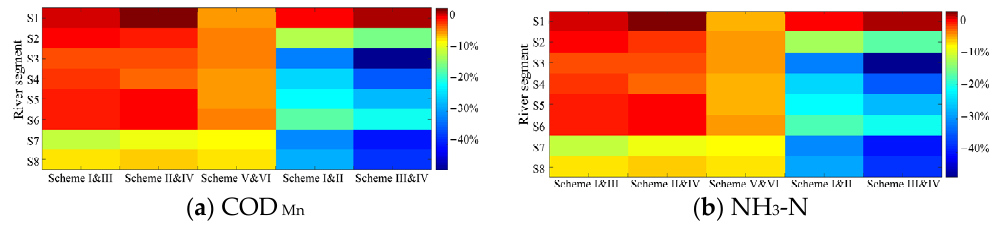
Figure 9. The WEC percentage changes between schemes under varied water availability and water demand conditions; ( a ) COD Mn ; ( b ) NH 3 -N.